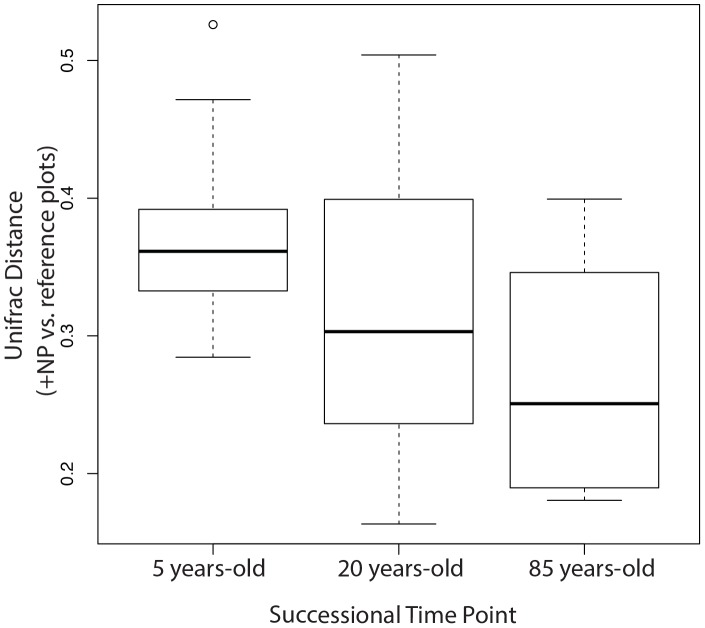
Relationship between +NP treatment-affected communities and reference communities.A box plot shows the average weighted UniFrac [43], [44] distance between +NP-treated communities and reference communities with increasing successional time. A Mantel test demonstrates that +NP communities show decreasing dissimiliarty as compared to the reference communities over advancing stages of succession (ρM = −0.35 P = 0.01).